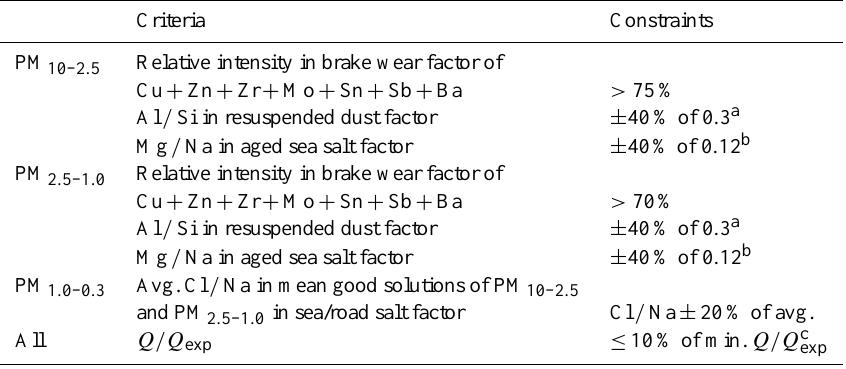
Table 1. Source profile